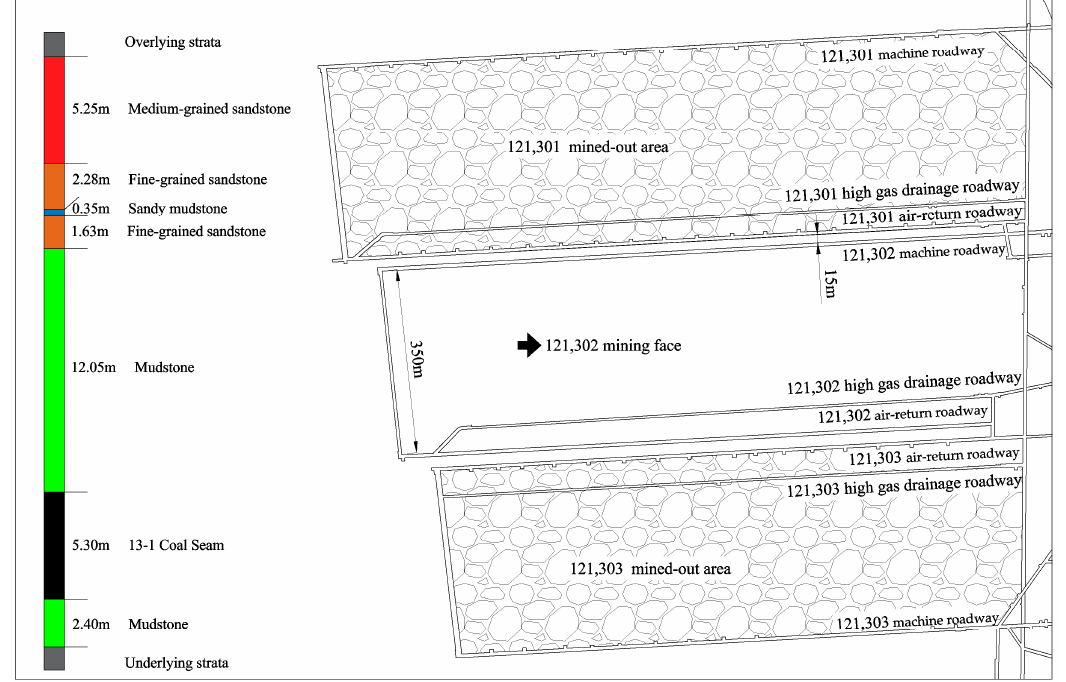
Figure 2. The 121,302 caving face layout and roof strata structure.